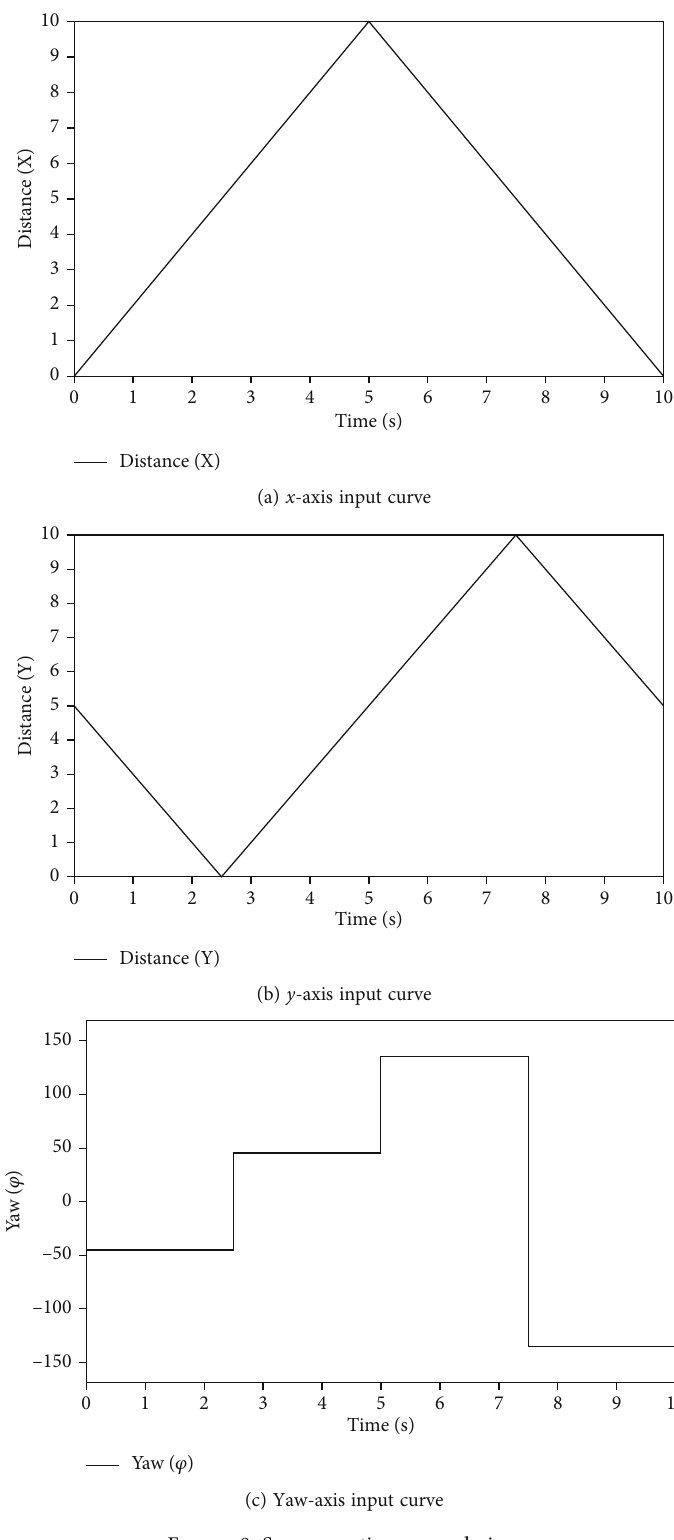
Figure 8: Square motion curve